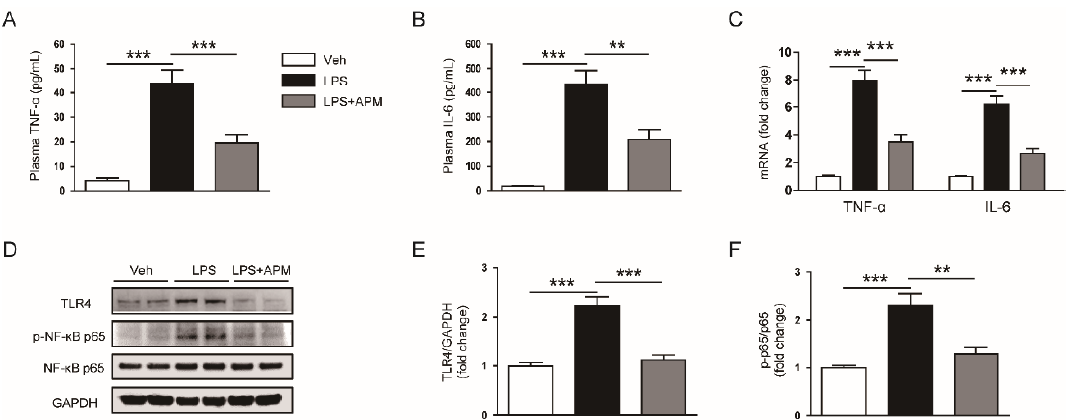
Figure 8. Effect of apamin on plasma and renal levels of cytokines, toll-like receptor 4 (TLR4) expression, and nuclear factor-κB (NF-κB) p65 phosphorylation in LPS-injected mice. ( A ) Plasma tumor necrosis factor-α (TNF-α) levels. ( B ) Plasma interleukin-6 (IL-6) levels. ( C ) The mRNA expression of TNF-α and IL-6 in kidney tissues. ( D ) Immunoblotting of TLR4, p-NF-κB p65, and NF-κB p65. ( E ) Quantification of immunoblot for TLR4. ( F ) Quantification of immunoblot for p-NF-κB p65. n = 8 per group. ** p < 0.01 and *** p < 0.001.